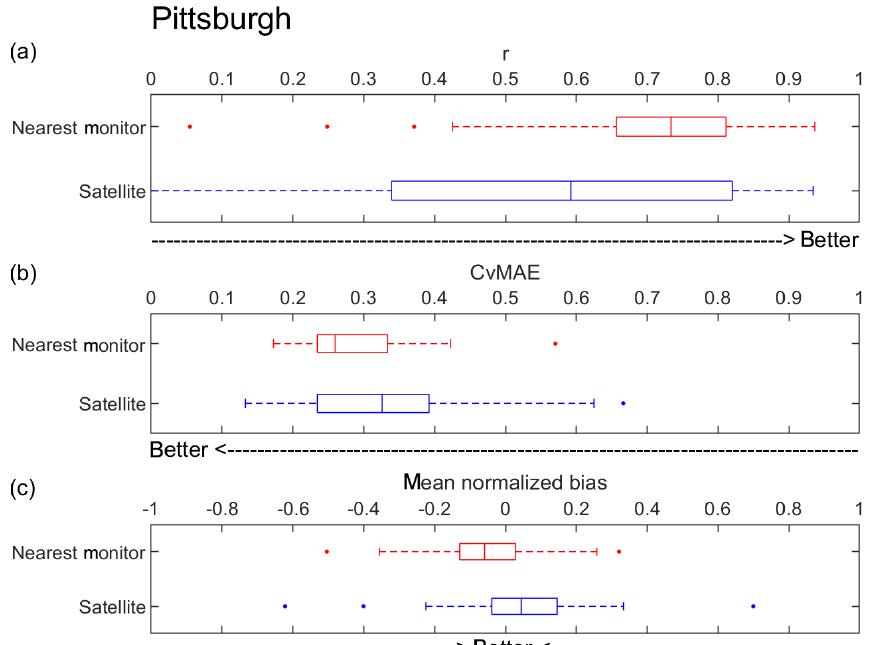
Figure 5. Comparison of performance metrics ( a correlation, b CvMAE, c MNB) for surface PM 2 . 5 estimated either from satellite AOD data (satellite) or from the nearest ground-level PM 2 . 5 monitor (nearest monitor) in the Pittsburgh area. Note that these performance metrics are not directly comparable to those presented in Fig. 3, as in this case a larger number of ground initialization sites (9 to 45, depending on the number of active sites in Pittsburgh at any particular time) are considered. Further, performance is now being assessed against the RAMP rather than the ACHD network (i.e., performance is assessed at the held-out active RAMP site); this is done to allow for comparability with the results from Rwanda presented in Fig. 6, where only RAMP data are